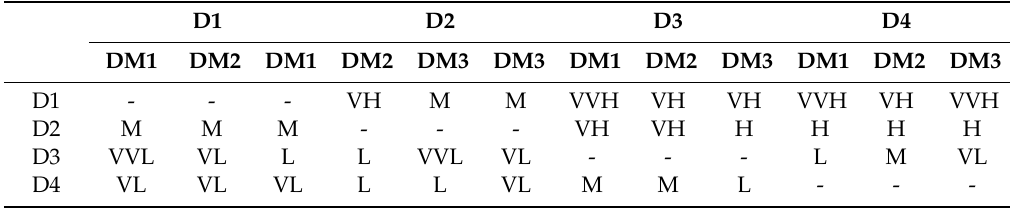
Table A1. Linguistic evaluations of the dimensions. D1: Macro-economic factors, D2: Socio-political factors, D3: Market-based factors, D4: Environmental factors.